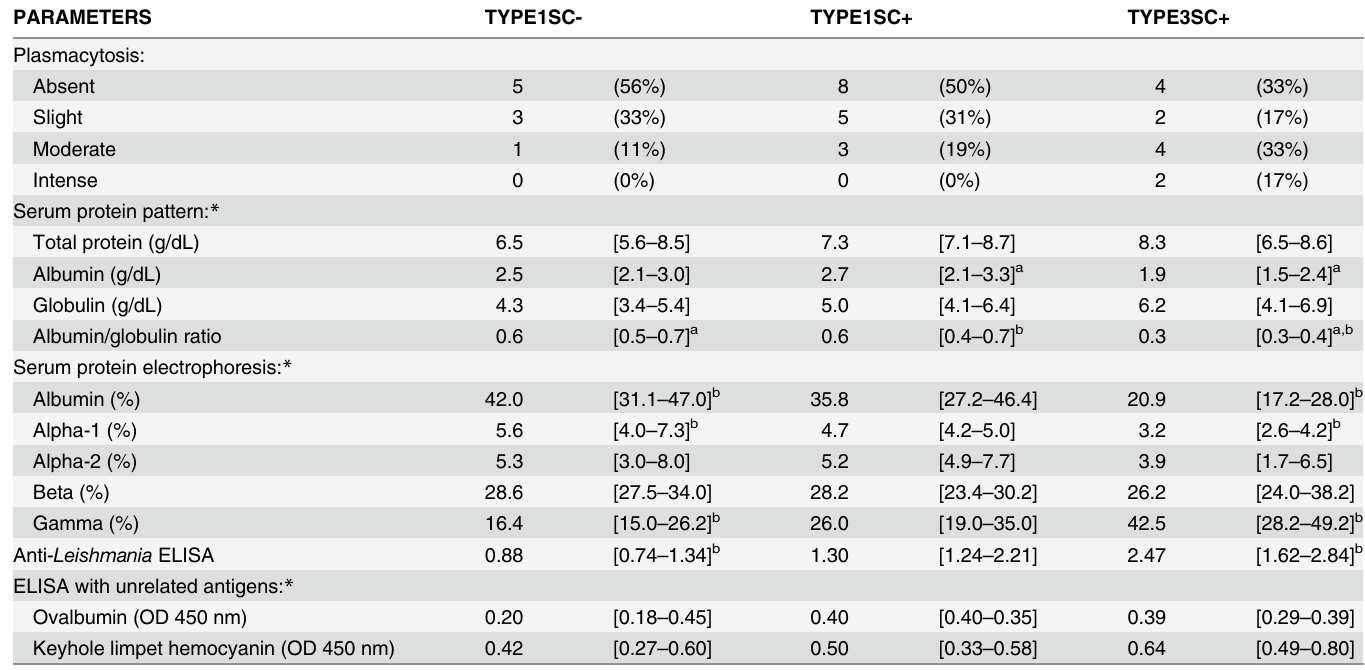
Table 3. Laboratory findings of included non-infected dogs, dogs without active infection with organized white pulp (TYPE1SC), infected dogs with organized white pulp (TYPE1SC+) and infected animals with disorganized white pulp